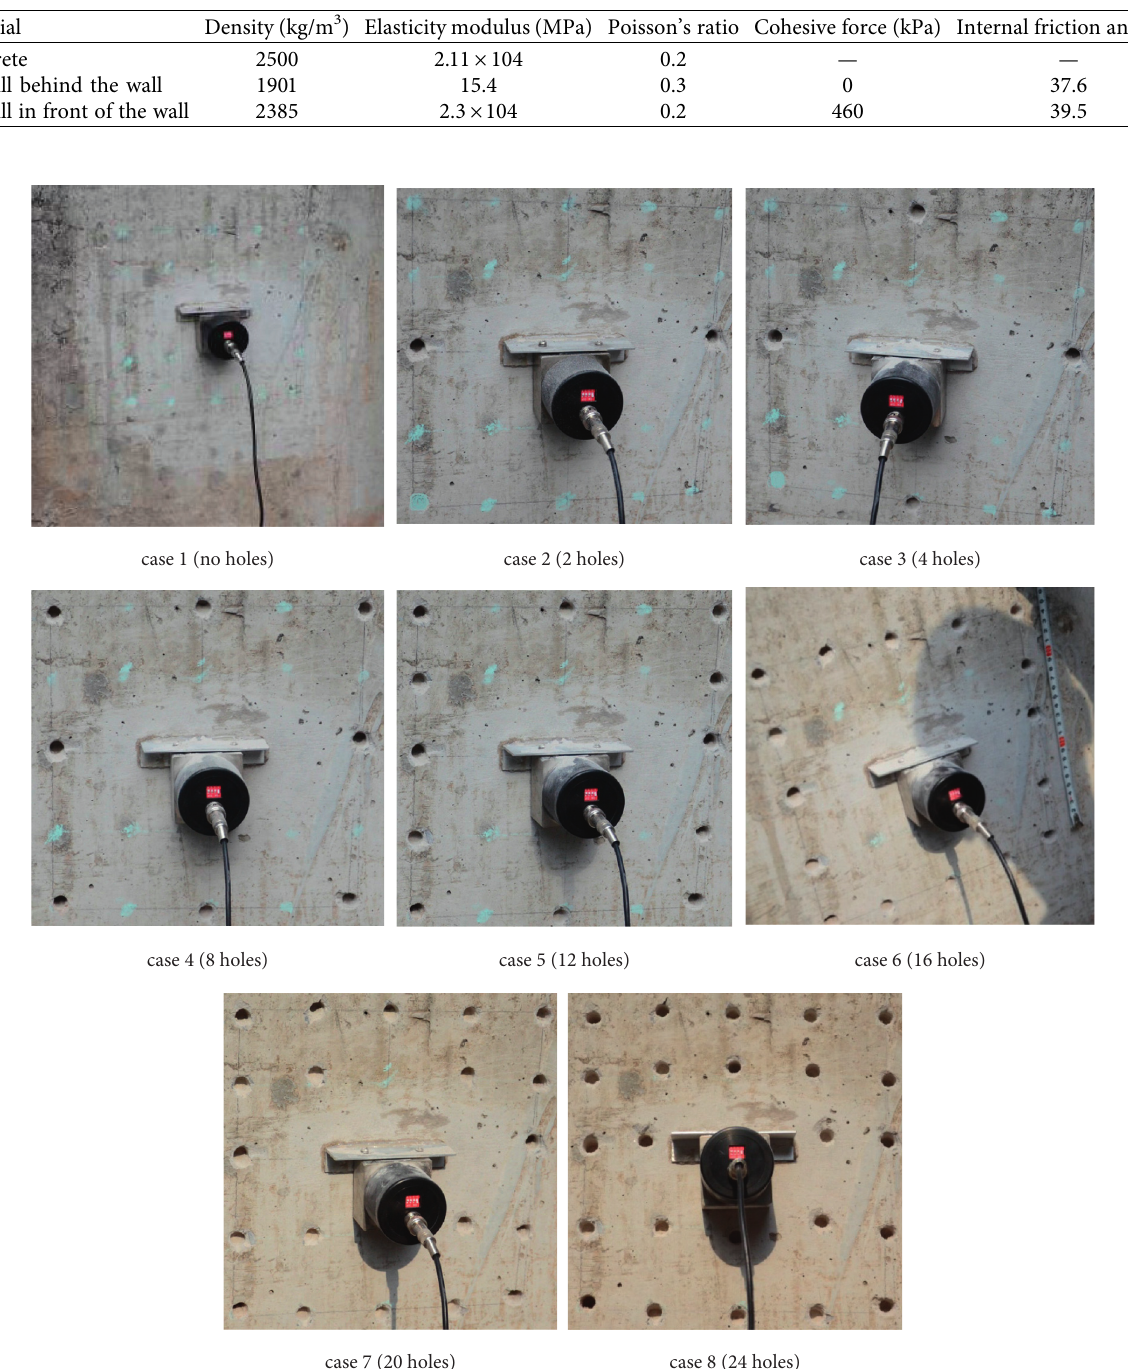
Figure 2: Partial